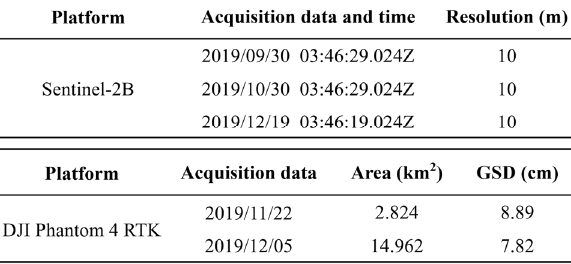
Table 1 . Sentinel-2 images and UAV data used in this